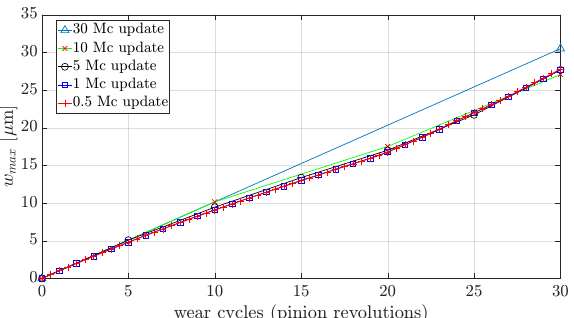
Figure 20. Maximum pinion wear depth from wear simulations with different geometry update